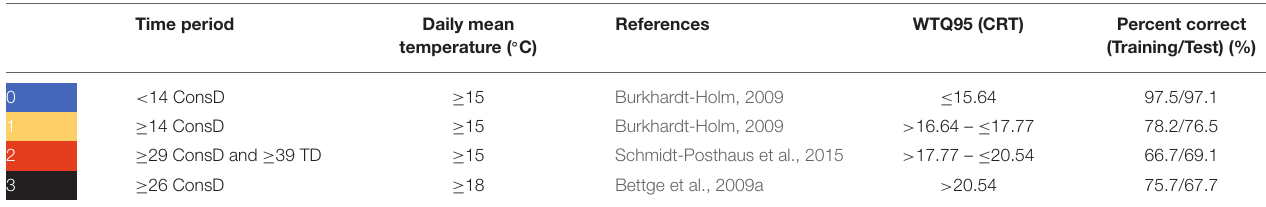
TABLE 3 | The categories of temperature-related risk of PKD (TR-PKD) with related time periods exceeding daily mean water temperature thresholds ( ◦ C). Time